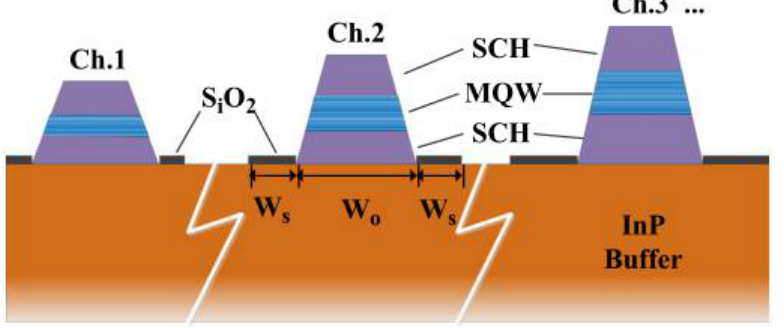
Figure 6. Selective area growth schematic (Zhang C et al. 2013 [11]). © Springer link. Copyright 2013 Science China Technological